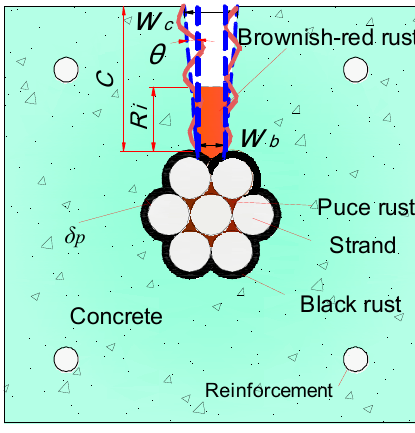
Figure 15. Simplified crack model.